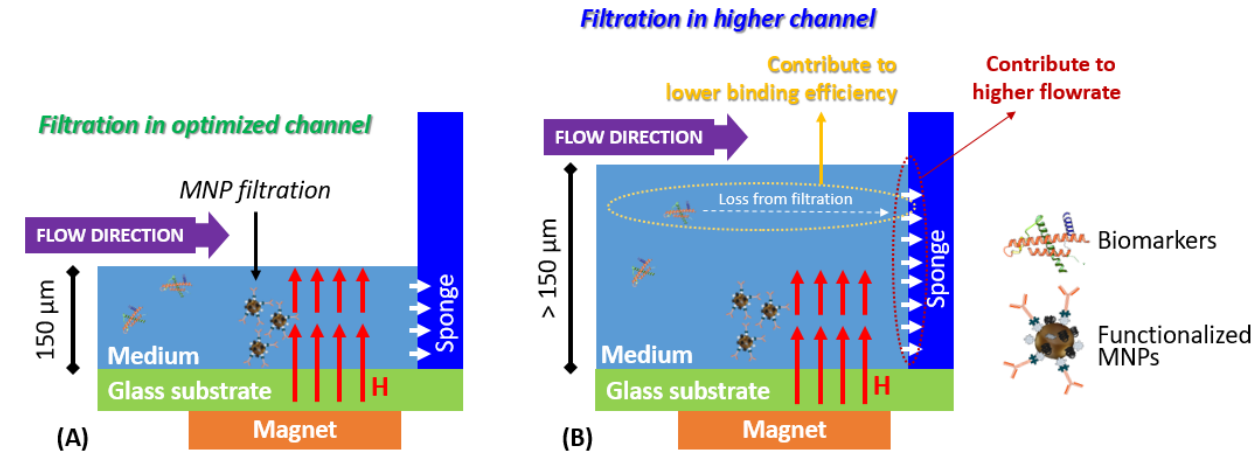
Figure 5. The critical role of the channel height of the microfluidic chip is to capture the target protein. ( A ) An suitable protein labeling in an optimized channel. ( B ) A higher channel reduces the protein labeling efficiency and increases the contact surface of the medium with the sponges.